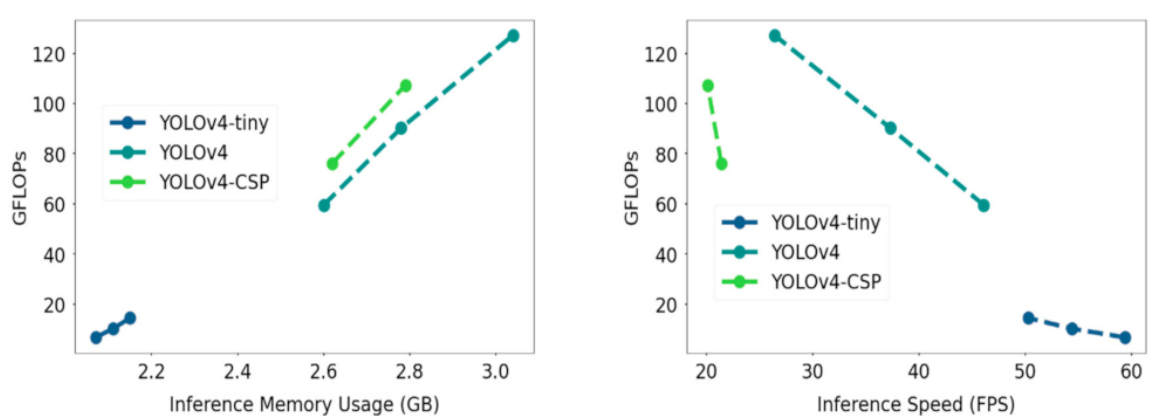
Figure 17. Relationship of Floating Point Operations per Second (FLOPs) with Inference GPU Memory Usage ( left ) and Inference Speed ( right ) for each YOLOv4 model. The specific values are given in Table